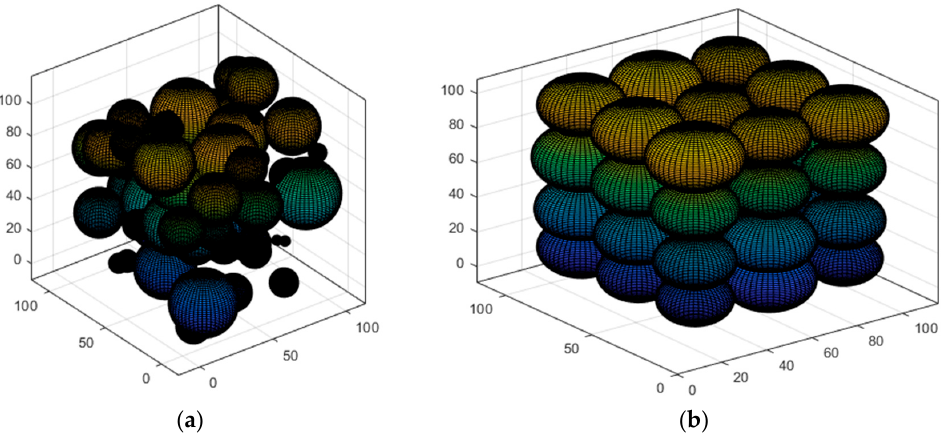
Figure 1. 3D-coverage enhancement scene: ( a ) Random deployment; ( b ) After coverage